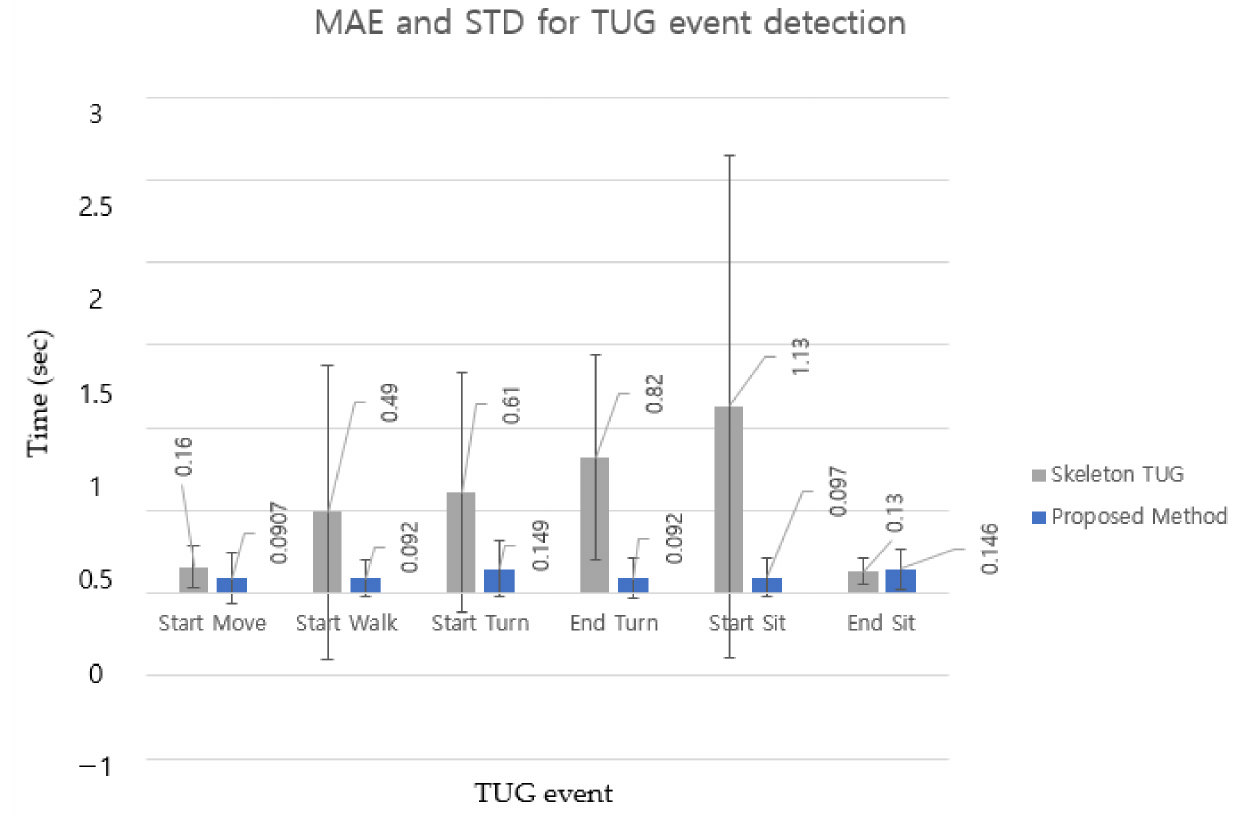
Figure 9. MAE and STD in seconds between skeleton TUG (gray bar) and the proposed method (blue bar) for each TUG event. Error bars are ± the STD of the values.